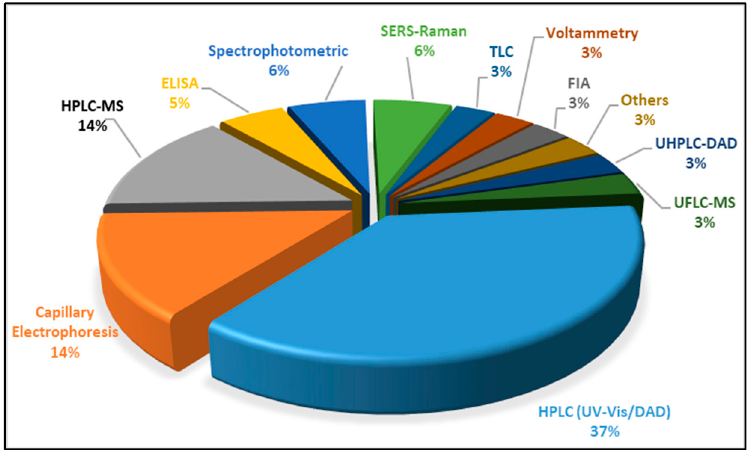
Figure 3. Distribution of techniques for the analysis of synthetic food colorants.